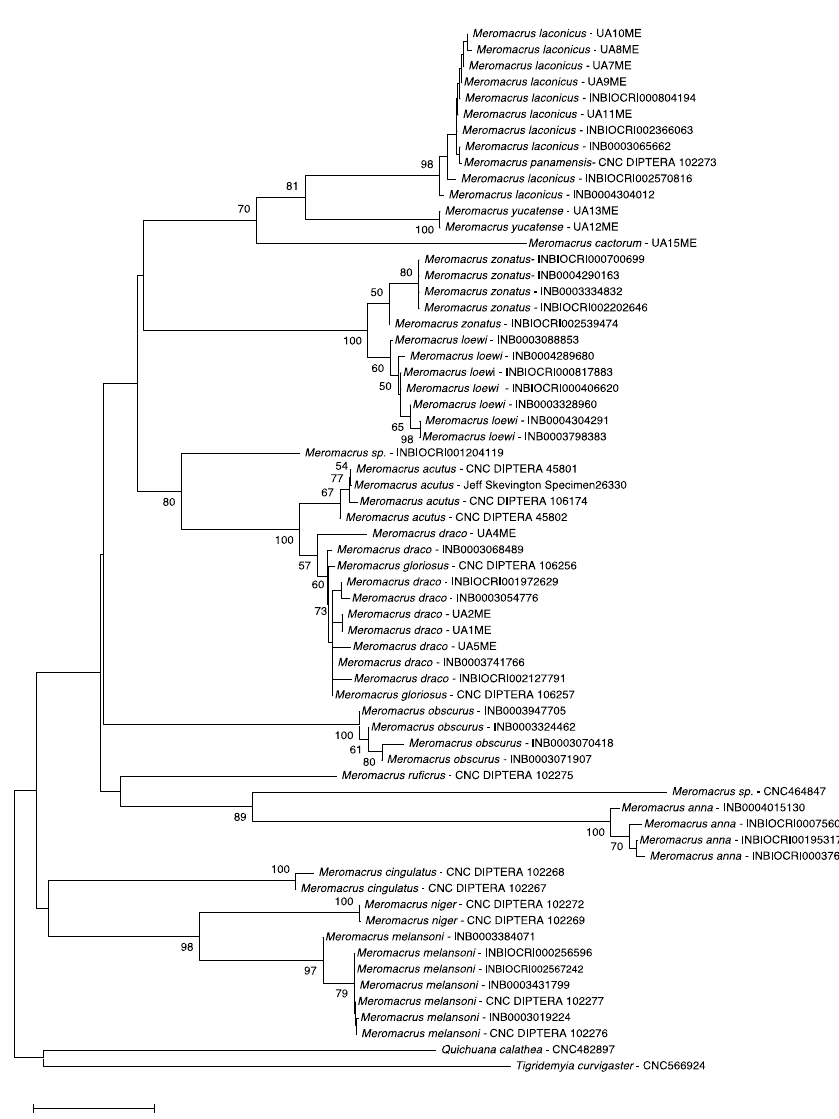
Figure 15. Neighbour-joining tree of all Meromacrus specimens genetically analysed using COI data. All data are available from the public dataset on BOLD: Meromacrus revision (DS-SYRMEROM). Synonyms: Meromacrus draco ( = Meromacrus gloriosus ), Meromacrus panamensis ( = Meromacrus laconicus ). Bootstrap supports over 50% are shown on the tree.